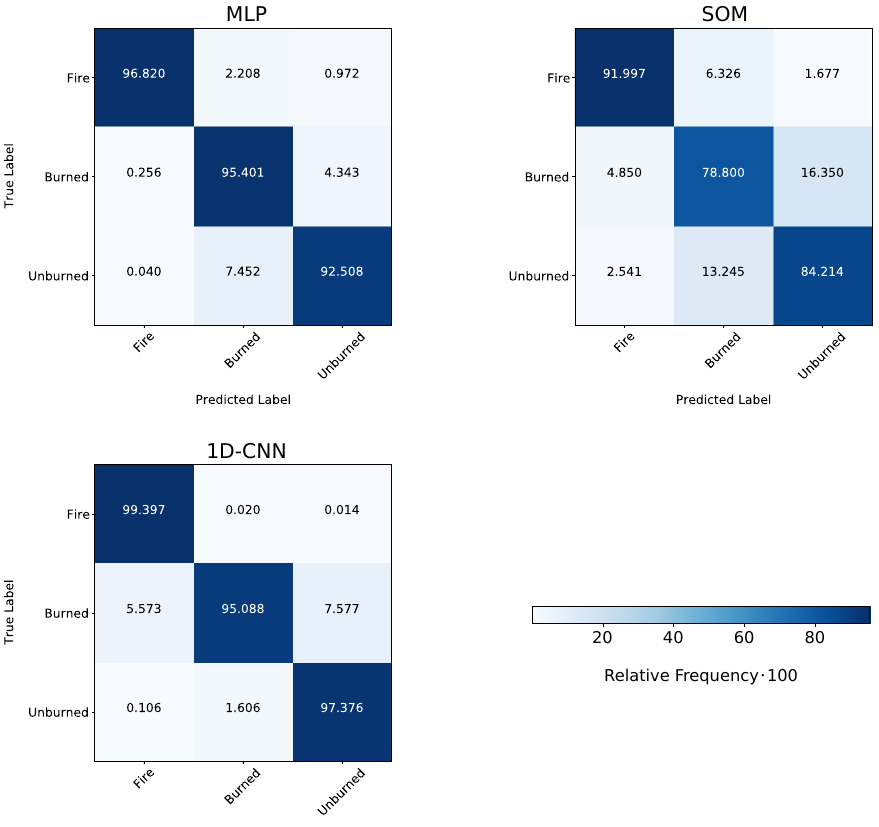
Figure A1. Normalized confusion matrices for the investigated models. The prediction was per- formed on the unbalanced Subset 2 and compared to the reference data. The ML models were trained on the training split of Subset 3